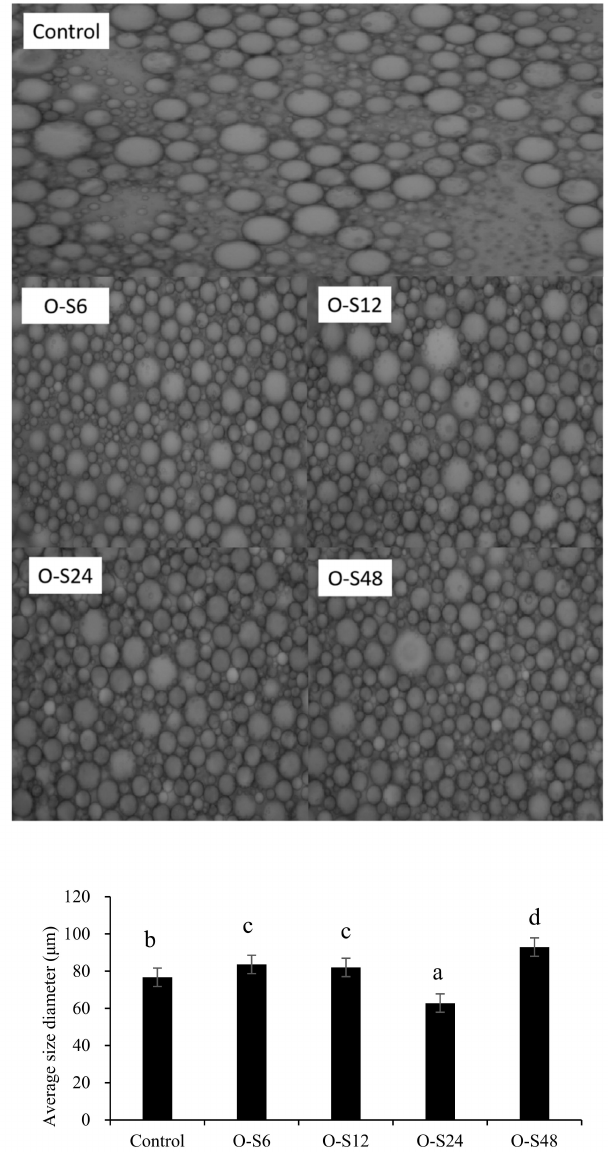
Figure 6. Microstructure of freshly prepared emulsions fabricated with ODF-SPI mixture (control) and ODF-SPI conjugates by dry heating for 6 h (O-S6), 12 h (O-S12), 24 h (O-S24) and 48 h (O-S48), and their average droplet sizes using 1:2 oil / water ratio. Significant di ff erences compared with the Control at p < 0.05 level were denoted by the